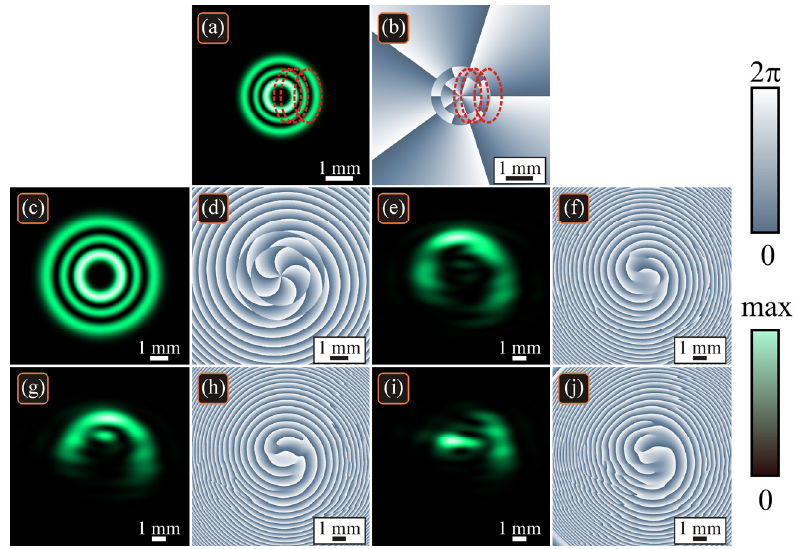
Figure 1. Intensity ( a , c , e , g , i ) and phase ( b , d , f , h , j ) distributions of a Laguerre–Gaussian beam in the initial plane ( a , b ), as well as after free space propagation, when the beam is not truncated ( c , d ) or truncated in the initial plane by an elliptical aperture in three possible cases: the optical vortex is within the aperture ( e , f ), on its edge ( g , h ), or outside the aperture ( i , j ). Three red dashed ellipses ( a , b ) show the aperture borders in all these three cases.